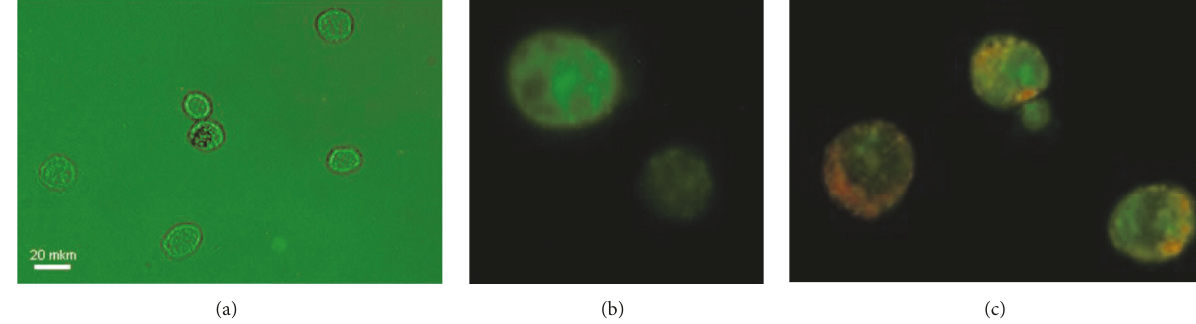
Figure 1: Nanocontainers D70-g-PAA tested on murine macrophages. (a) Murine macrophages microphotograph. (b) Murine macrophages under fluorescent microscope without nanocontainers. (c) Murine macrophages with nanocontainers in phagosomes under fluorescent microscope, stained with Acridine Orange.